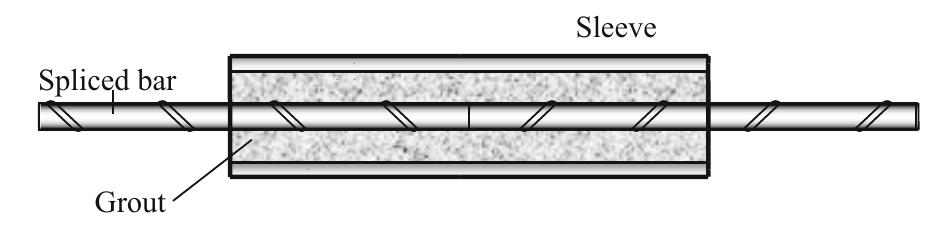
Fig. 1 Components of a typical grouted splice sleeve.